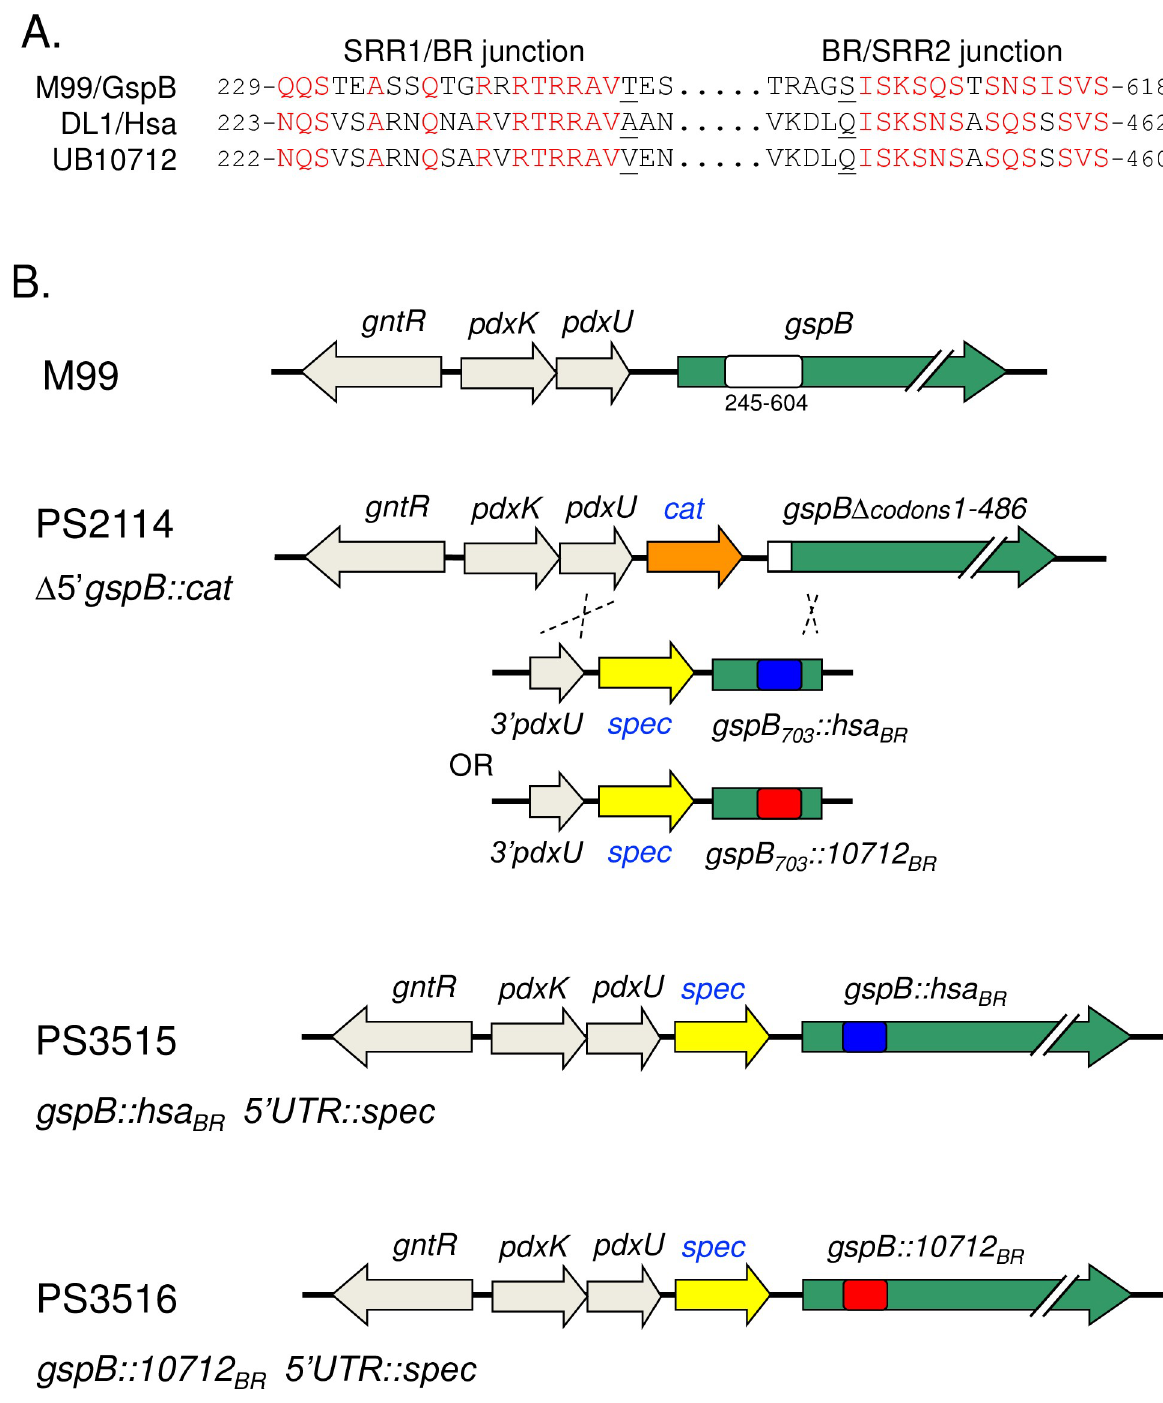
Fig 3. Design of isogenic variant strains of S . gordonii M99. Strains were designed to express GspB variants in which amino acid residues 248 to 604 of GspB (GenBank accession number AAL13053) were replaced with residues 242 to 448 of Hsa (ABV10391) or 241 to 446 of the SRR glycoprotein homolog from S . gordonii UB10712 (WP_045635027). A: Alignment of the BR domain junctions. Conserved amino acids are indicated in red type. T248 and S604 of GspB, A242 and Q448 of Hsa, and V241 and Q446 of the UB10712 homolog are underlined. B: Strategy to replace the GspB BR coding region in the native S . gordonii chromosomal locus. PS2114 is a derivative of S . gordonii M99 that has a deletion of gspB codons 1 to 486 and a cat gene in the upstream non-coding region [30]. Chimeric sequences were introduced into the S . gordonii chromosome via a strategy that involved recombination by double-crossover between gspB codons 605–703 and the upstream pdxU gene.